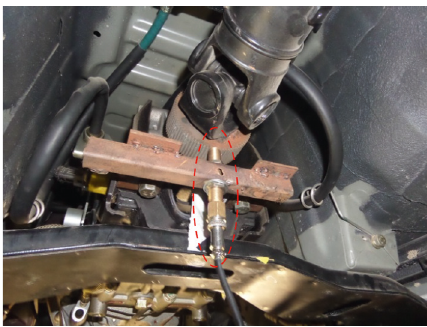
Figure 13: Torsional vibration measured at propeller shaft input end.